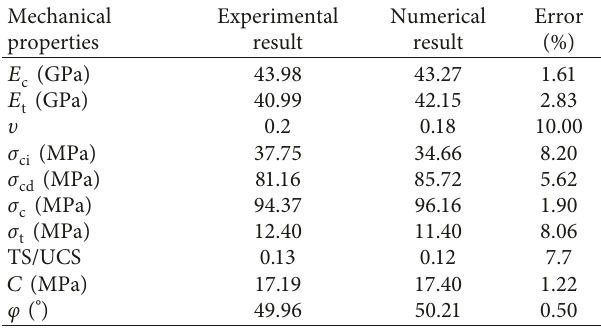
Figure 18: Axial stress-strain curve and volumetric-axial strain curve from the numerical uniaxial compression test. Table 5: Comparison of mechanical properties of the Sanshandao granite from the experimental and numerical